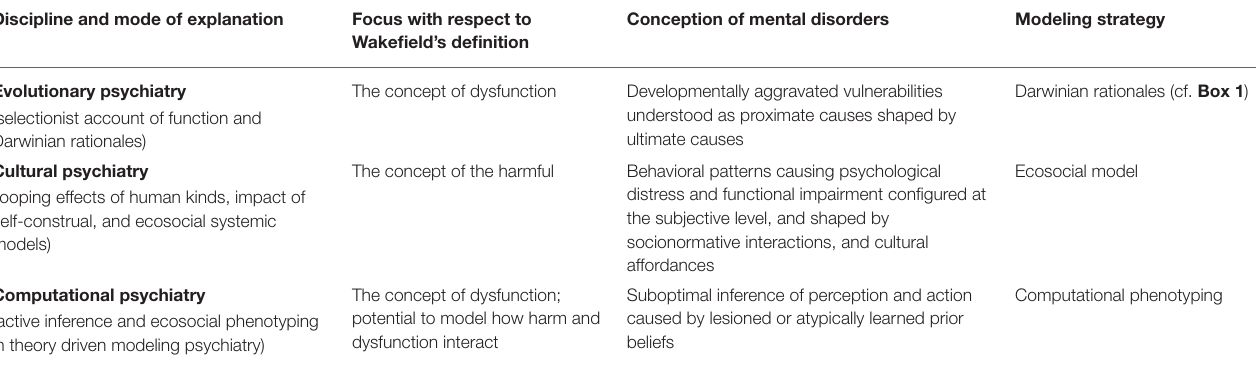
TABLE 1 | Modes of explanation and modeling